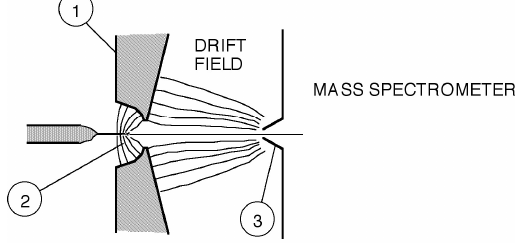
Figure 10 . Concept design, version